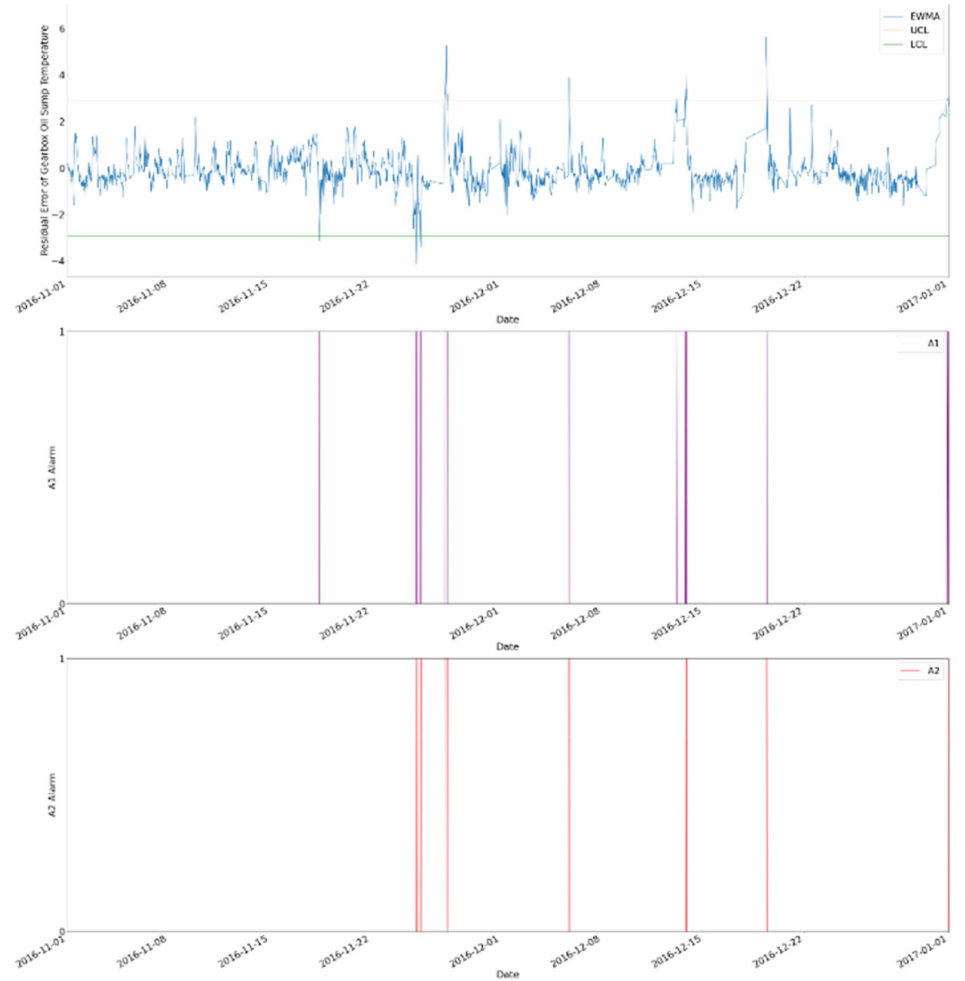
Figure 25. EWMA Chart with A1 and A2 Alarms from November 2016 to January